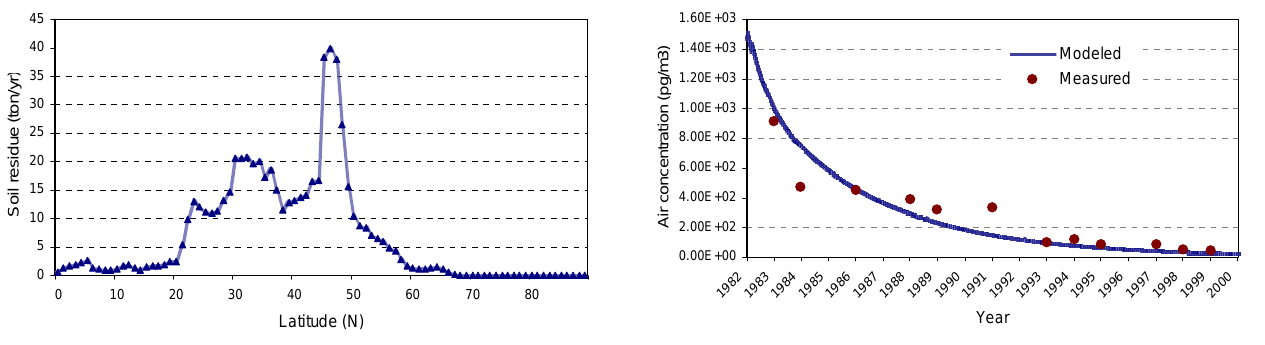
Fig. 7. Mean α -HCH soil residue (tonyr − 1 ) in 1980, zonally- averaged over the Northern Hemisphere.